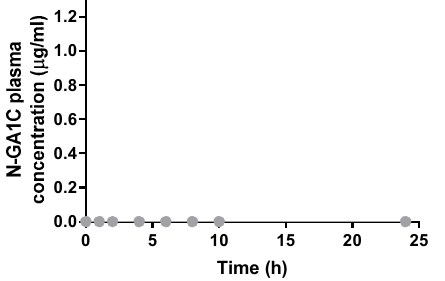
Figure 2. N-GA1C’s systemic absorption is limited after oral administration. Plasma concentration of N-GA1C was monitored after oral administration of N-GA1C (10 mg/kg). Data are presented as mean ± s.e.m. from a representative experiment ( n = 5) from 2 independent experiments.